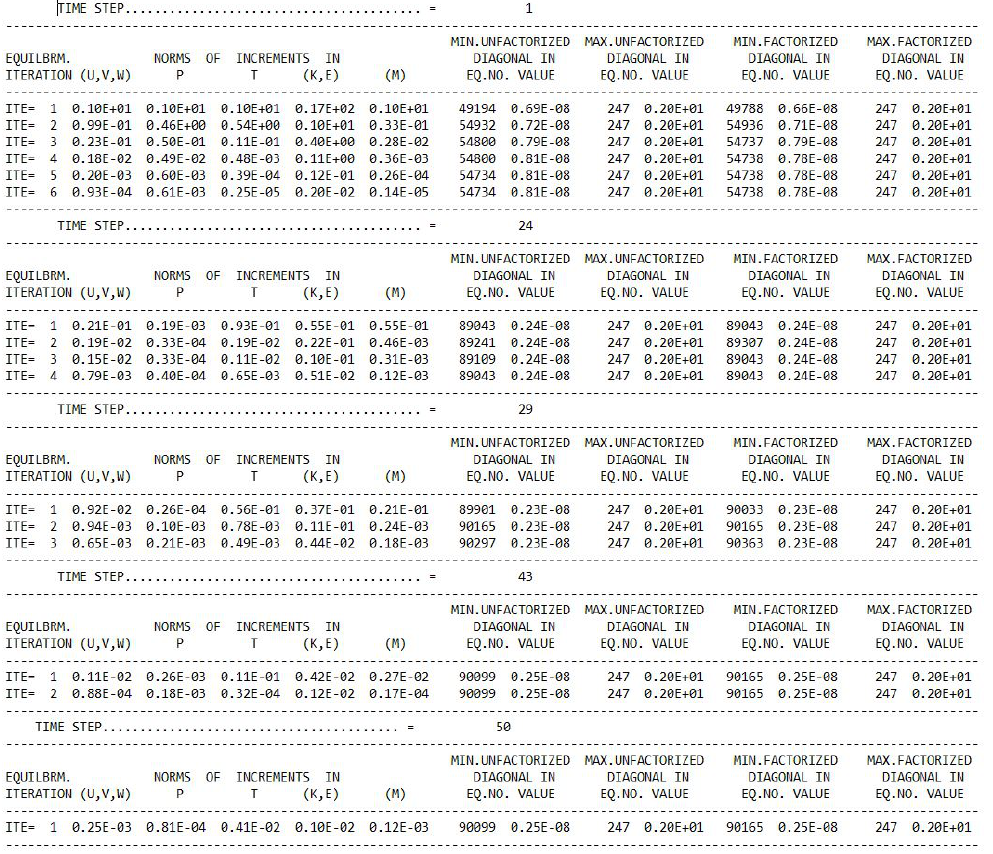
Figure 5. ADINA convergence ratios for velocity vector, pressure, temperature, turbulent kinetic energy, turbulent dissipation rate, and mass concentration.